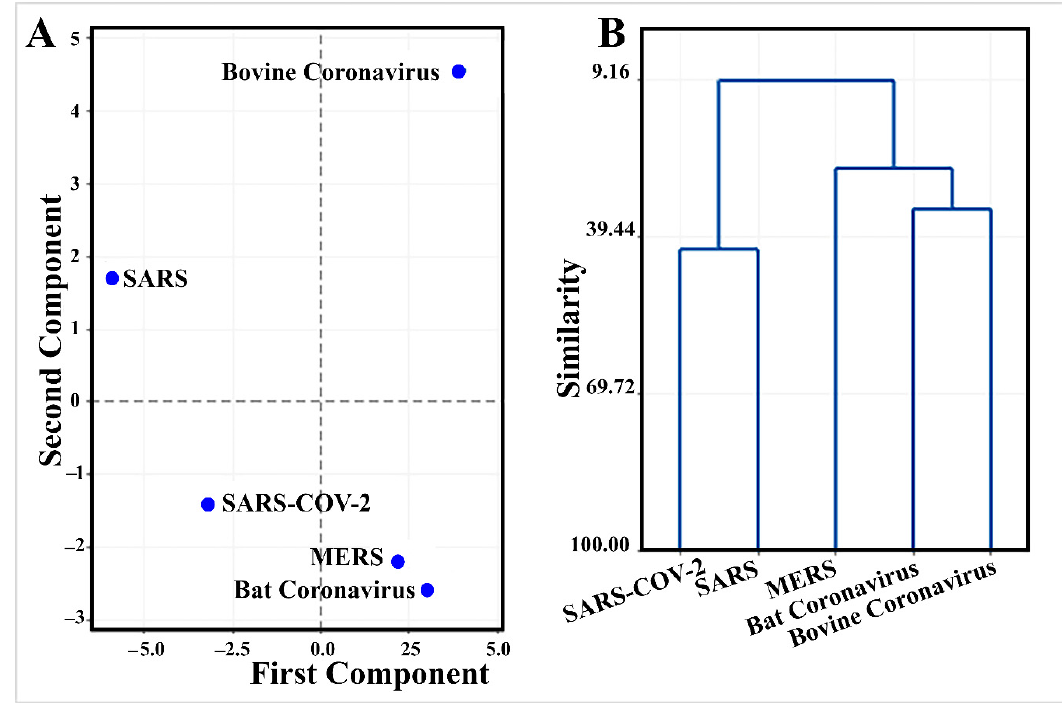
Figure 6. Multivariate analysis of thermodynamic binding energy values of the leader sequence of coronaviruses against mined inhibitory microRNAs (Table 3) demonstrates a unique pattern for SARS-CoV-2 evolution. ( A ) Principal component analysis discriminates SARS-CoV-2 from other coronaviruses. ( B ) Clustering shows that SARS-CoV-2 has only 41.6% similarity to SARS in its pattern of binding to microRNAs.